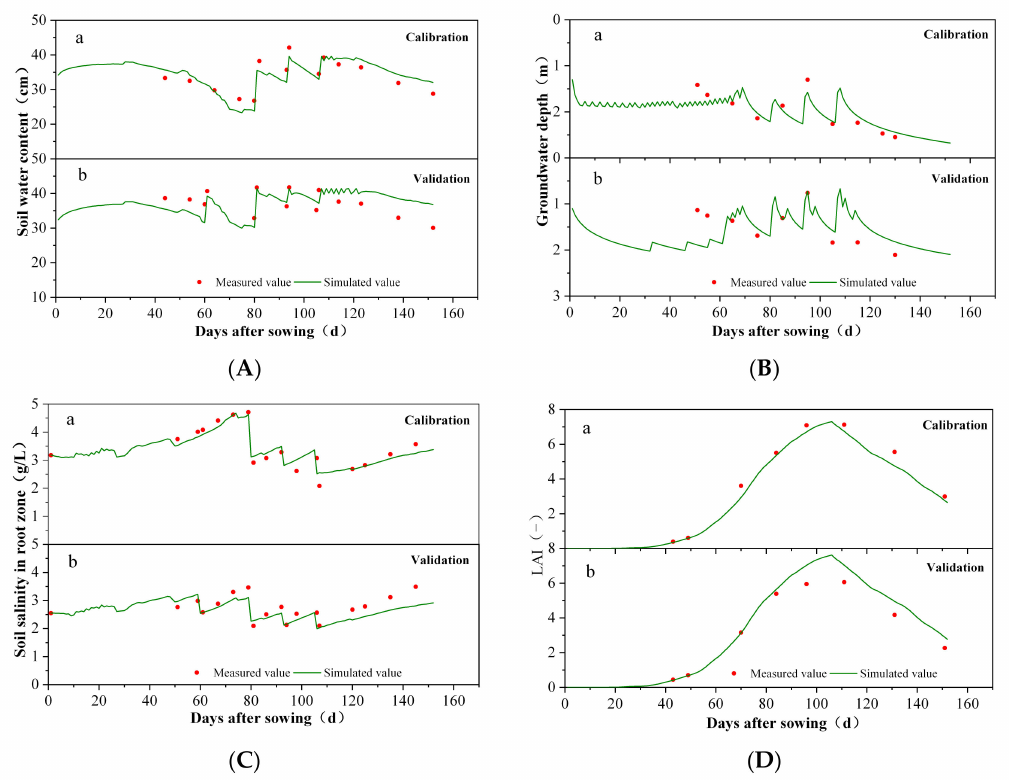
Figure 2. ( A – D ) Simulated versus measured soil water content, soil salinity, groundwater depth and leaf area index under di ff erent groundwater depths during calibration in S1 and validation in S2. ( A ) is that simulated versus measured soil water content, ( B ) is that simulated versus measured soil salinity, ( C ) is that simulated versus measured groundwater depth and ( D ) is that simulated versus measured leaf area